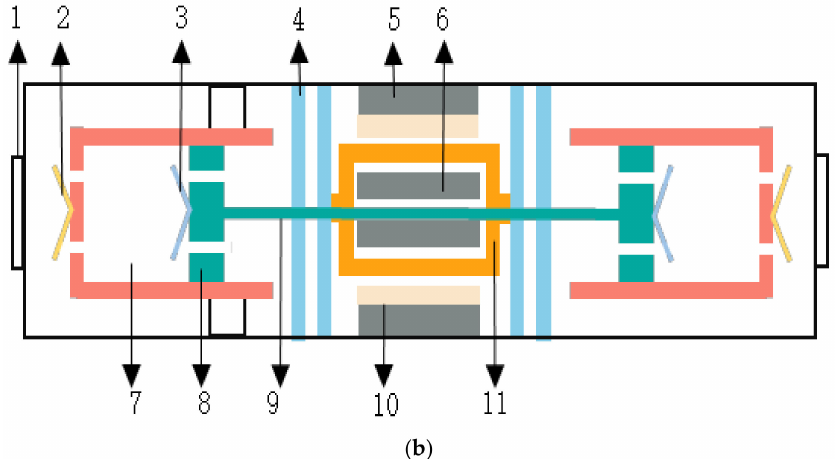
Figure 1. ( a ) the compositions of a SVLC; ( b ) the compositions of a SDVLC (1. sight window 2. discharge valve 3. suction valve 4. flexure spring 5. outer iron 6. inner iron 7. cylinder 8. piston 9. spindle 10. permanent magnet 11. coil).